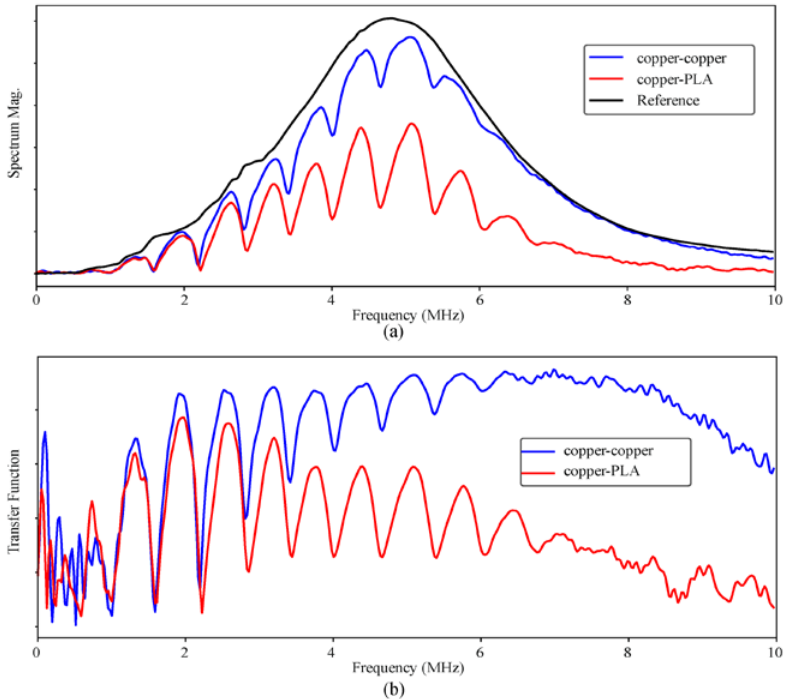
Figure 9. ( a ) Examples of spectrums of A-scans at different interfaces compared with the spectrum of the reference (copper) A-scan. ( b ) Examples of resulting resonant transfer functions.